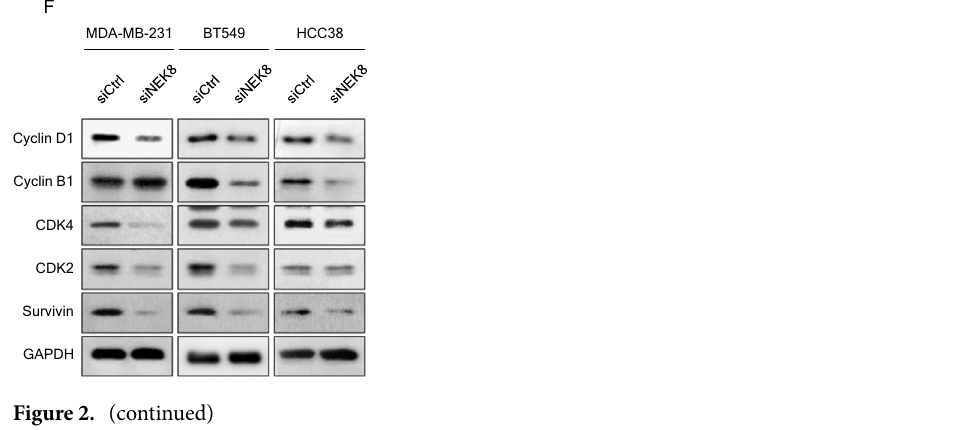
(Fig. 6B,C). We transplanted both control and NEK8-knockdown MDA-MB-231 cells into the mammary fat pads of female NOD.Cg- Prkdc scid Il2rg tm1Wjl /SzJ (NSG) mice (n = 3) and observed the growth of tumours for 35 days. Also, NEK8 knockdown significantly reduced tumour volume and weight (Fig.